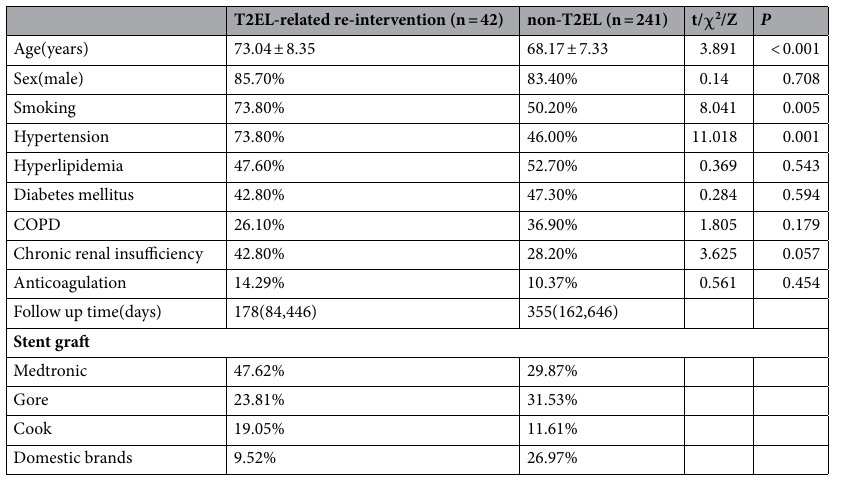
Table 1. Demographic characteristics of patients. COPD Chronic obstructive pulmonary disease.